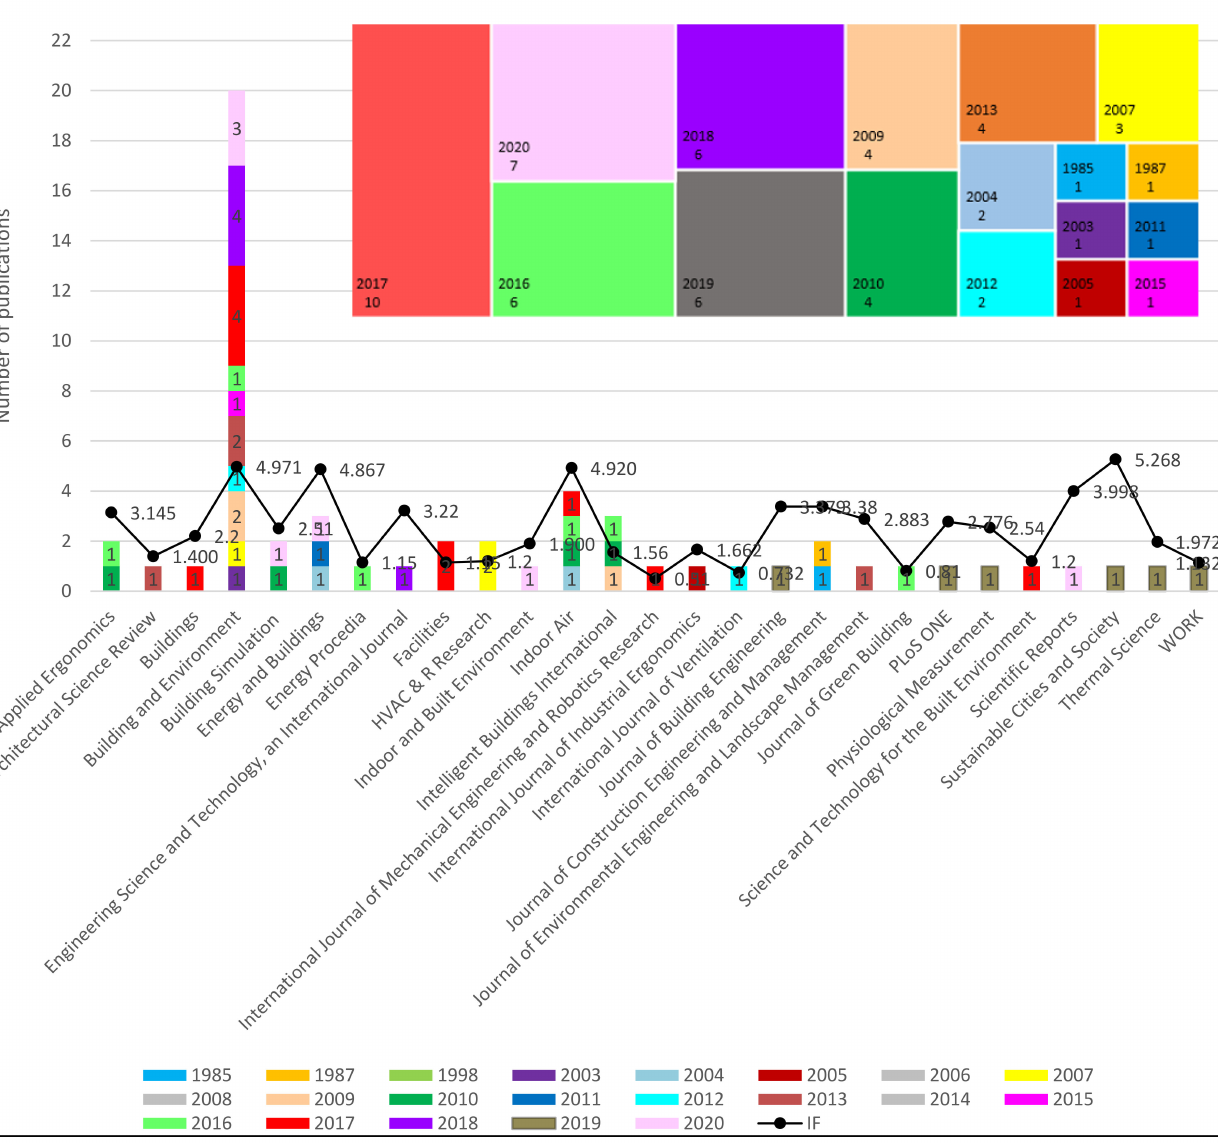
Figure 2. Co-occurrence